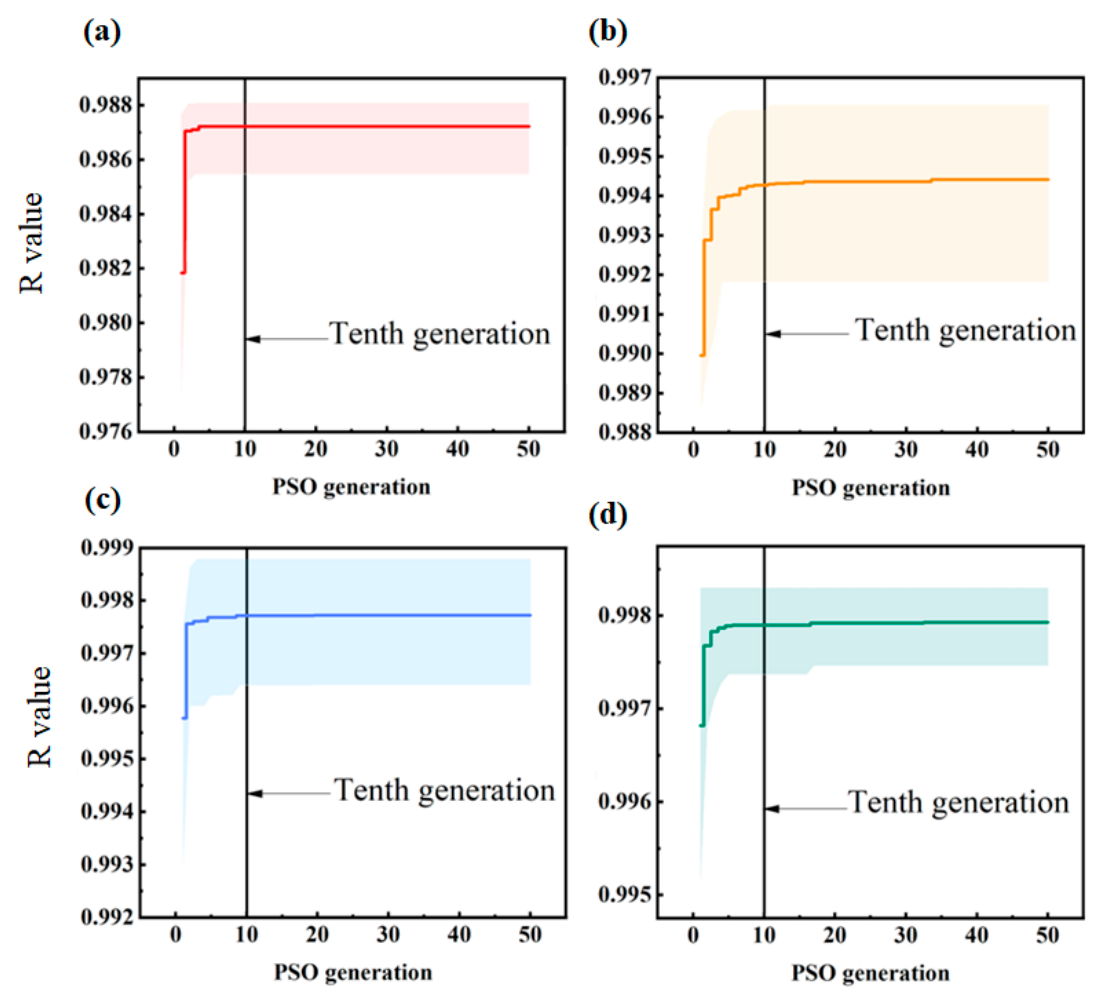
Figure 7. The change of CV training performance R with PSO iterations on datasets ( a ) K c , ( b ) K h , ( c ) K m , and ( d ) K v . Each generation took about 2 h to calculate.